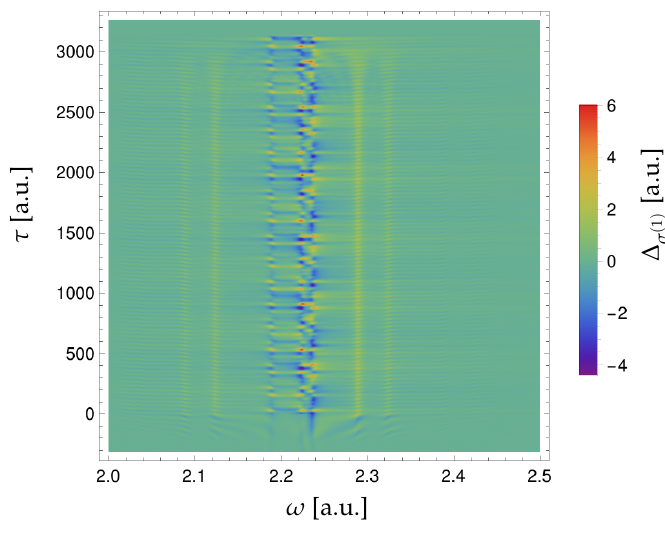
= σ ( 1 ) ( ω , τ ) − σ ( 1 ) ( ω , ∞ ) σ ( 1 )